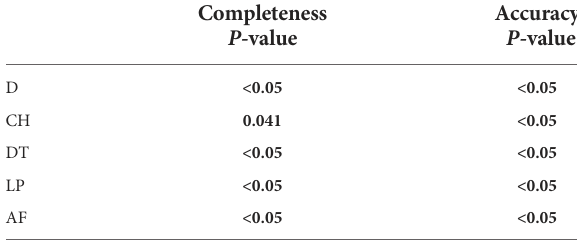
TABLE 6 Comparison of completeness and accuracy for entire data values.